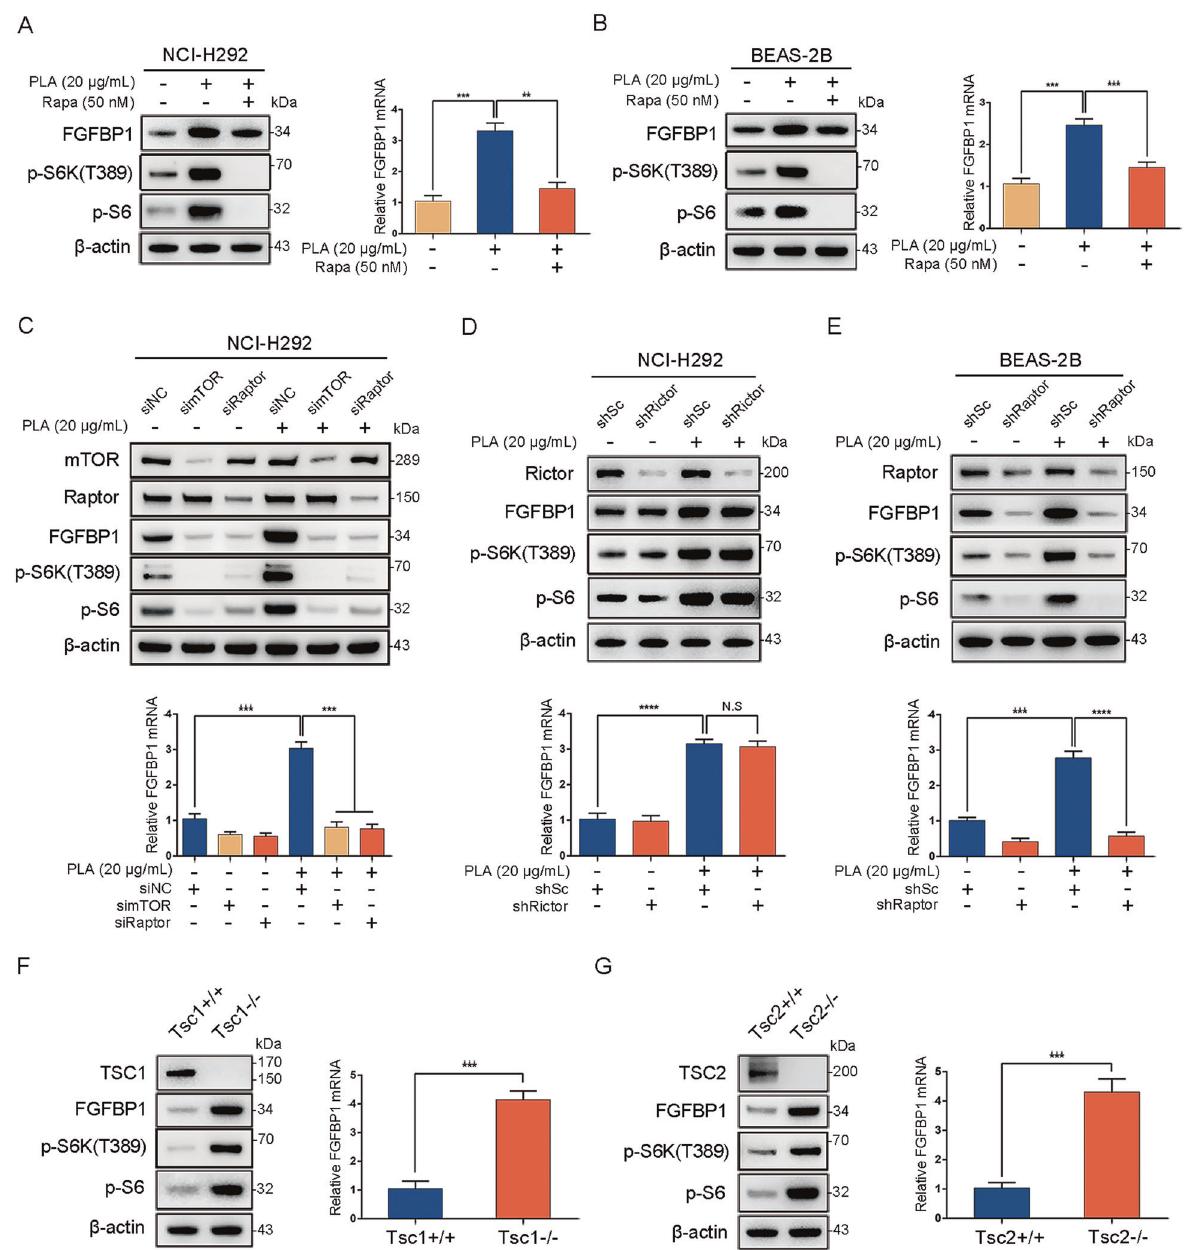
Fig. 3 PLA upregulates FGFBP1 expression through activation of mTORC1. A , B NCI-H292 ( A ) and BEAS-2B ( B ) cells were pretreated with PLA (20 μ g/mL, 12 h) before rapamycin (50 nM, 12 h) treatment. C NCI-H292 cells were transfected with siRNA targeting mTOR (simTOR), Raptor (siRaptor), or the control (siNC) for 48 h before PLA (20 μ g/mL, 12 h) treatment. D NCI-H292/shRictor or NCI-H292/shSc cells were treated with PLA (20 μ g/mL) for 24 h. E BEAS-2B/shRaptor or BEAS-2B/shSc cells were treated with PLA (20 μ g/mL) for 24 h. F Tsc1 + / + and Tsc1 − / − MEFs. G Tsc2 + / + and Tsc2 − / − MEFs. A – G All cell lysates were collected for western blot with the indicated antibodies ( A , B , F , and G , left panels and C – E , upper panels) and FGFBP1 mRNA was detected by qRT-PCR ( A , B , F , and G , right panels and C – E , lower panels). Results are shown as mean ± SD from three independent experiments. ** P < 0.01; *** P < 0.001; **** P < 0.0001; NS not signi fi